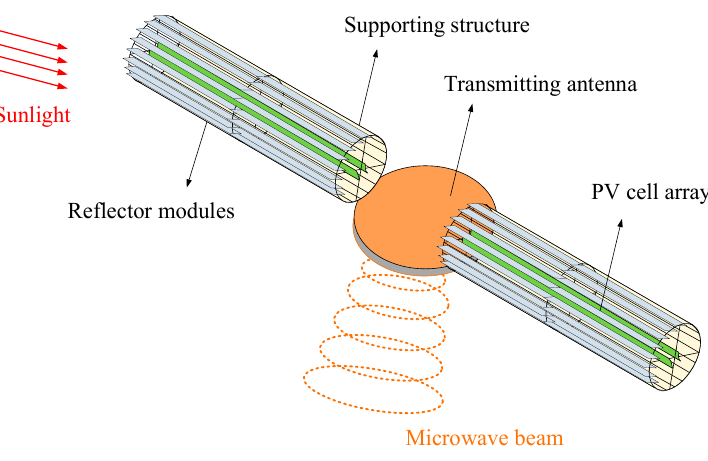
Figure 12. Illustration of the optimal model.